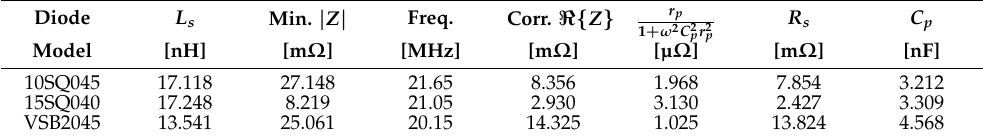
Table 9. AC small-signal parameters for the three diodes.